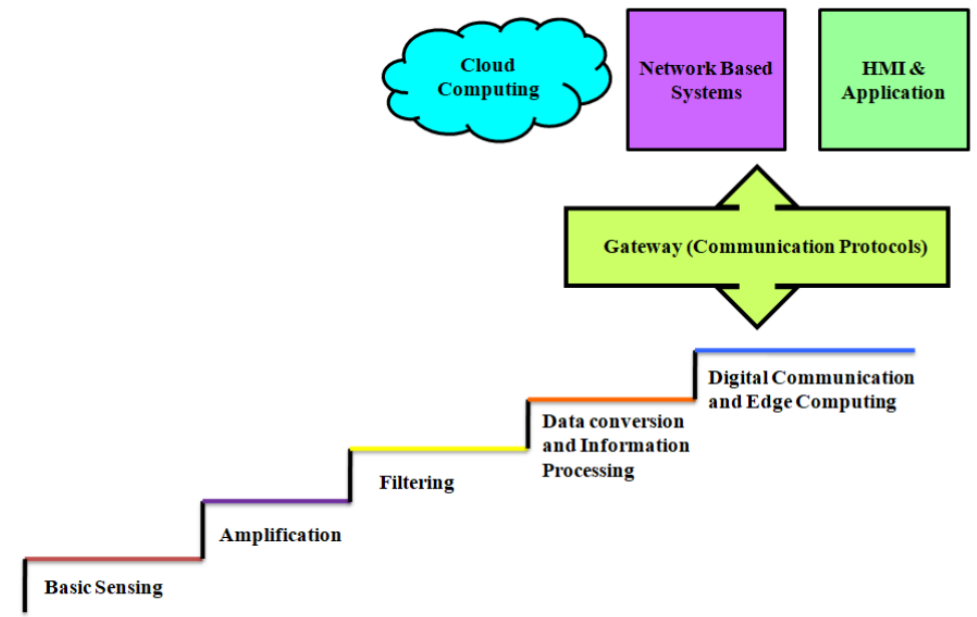
Figure 8. Intelligent Sensing in Communication